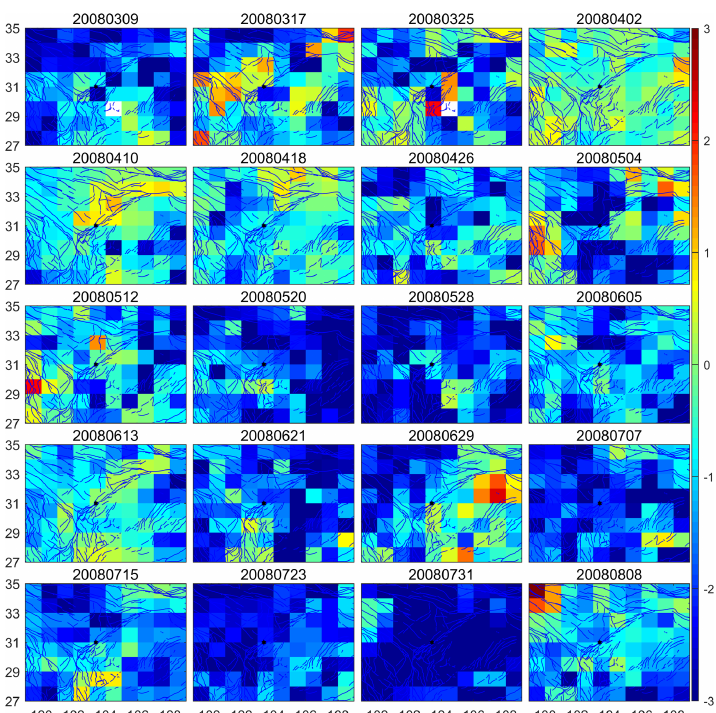
Figure 8. Gradient of 400 to